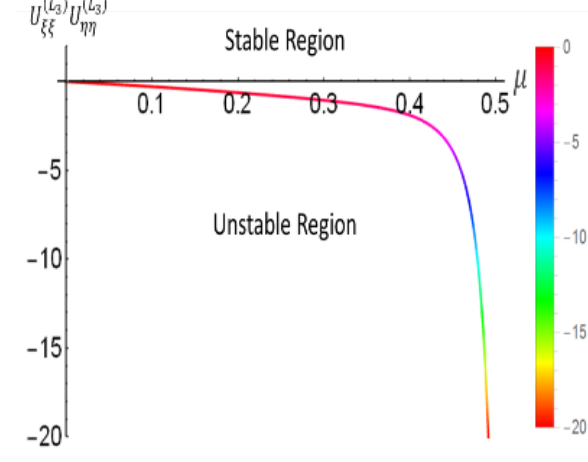
Figure 9. Stability region vs. µ for L 3 for ERTBP with oblate and triaxial